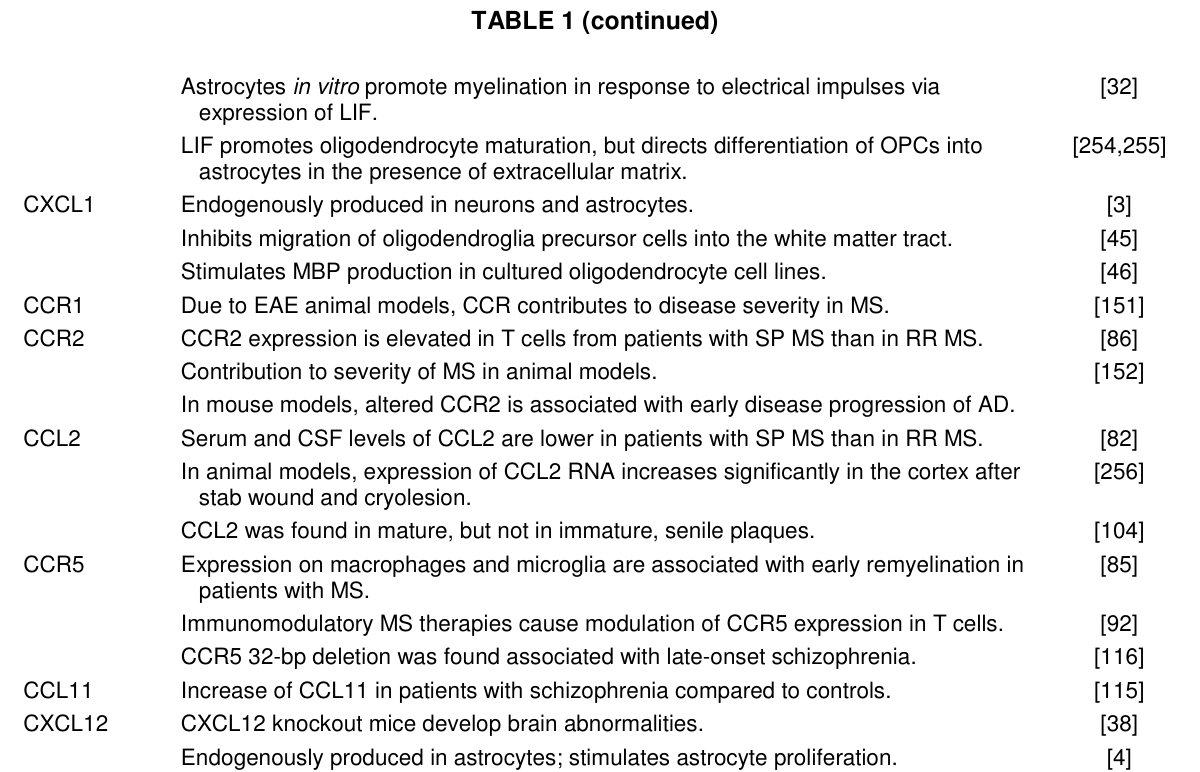
Definitions for abbreviations may be found in the